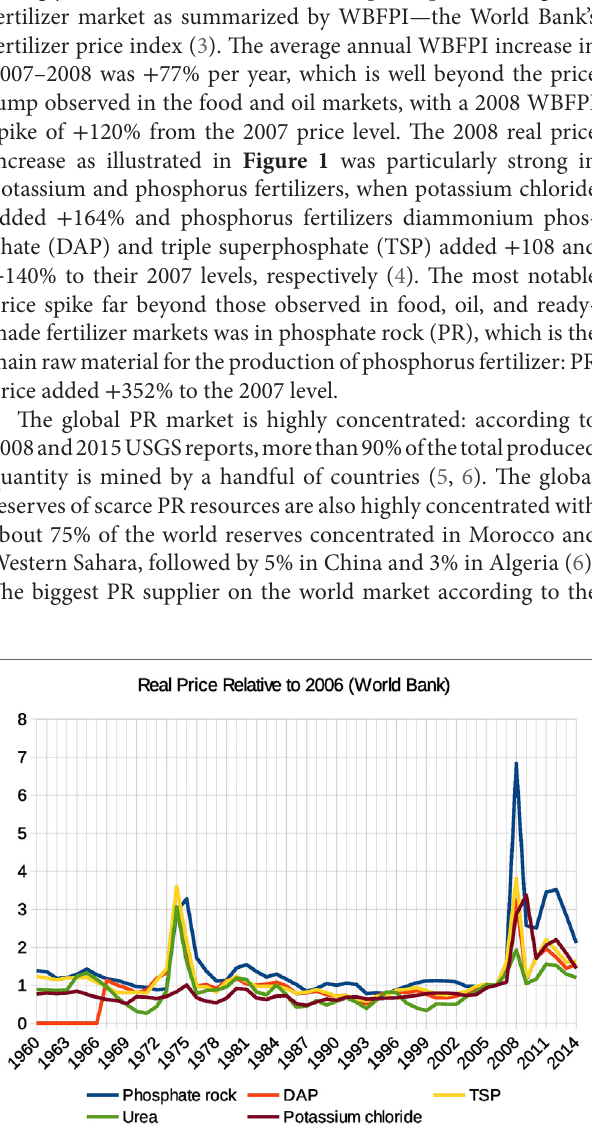
FigUre 1 | Historical price dynamics of phosphate rock, diammonium phosphate (DAP), triple superphosphate (TSP), urea, and potassium chloride (muriate of potash). Source: World Bank Commodity Price Data (The Pink Sheet), annual indices 1960 to present, real 2005 US dollars.